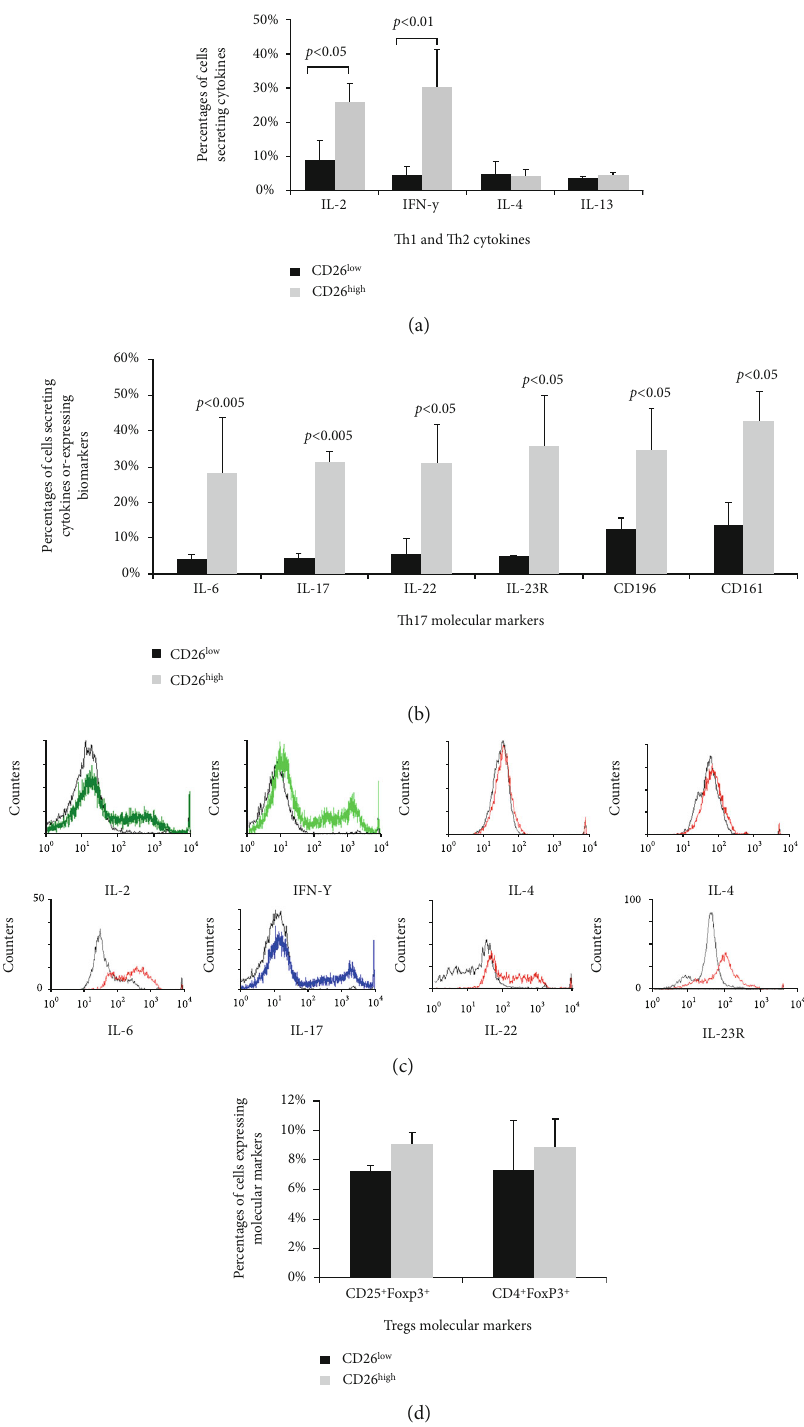
Figure 6: Percentage of cells secreting di ff erent cytokines in the CD26 low and CD26 high groups. After separation, the cells in the CD26 low group and the CD26 high group were labeled with di ff erent monoclonal antibodies against cytokines or surface markers at 4 ° C for 30min and then measured by fl ow cytometry. (a) The percentages of cells secreting Th1 and Th2 typical cytokines in the CD26 low and CD26 high groups. (b) The percentages of cells secreting Th17 typical cytokines or expressing Th17 typical biomarkers in the CD26 low and CD26 high groups. (c) Overlay histograms demonstrate the relative expression of cells secreting di ff erent cytokines in the CD26 low and CD26 high groups. The black line indicates the values of CD26 low group cells while the color lines indicated the values of CD26 high group cells. (d) The percentages of cells expressing Tregs typical biomarkers in the CD26 low and CD26 high groups. Data represented meanvalue ± SD from a minimum of fi ve independent experiments with at least fi ve healthy donor HPBL samples, and each experiment was repeated more than three